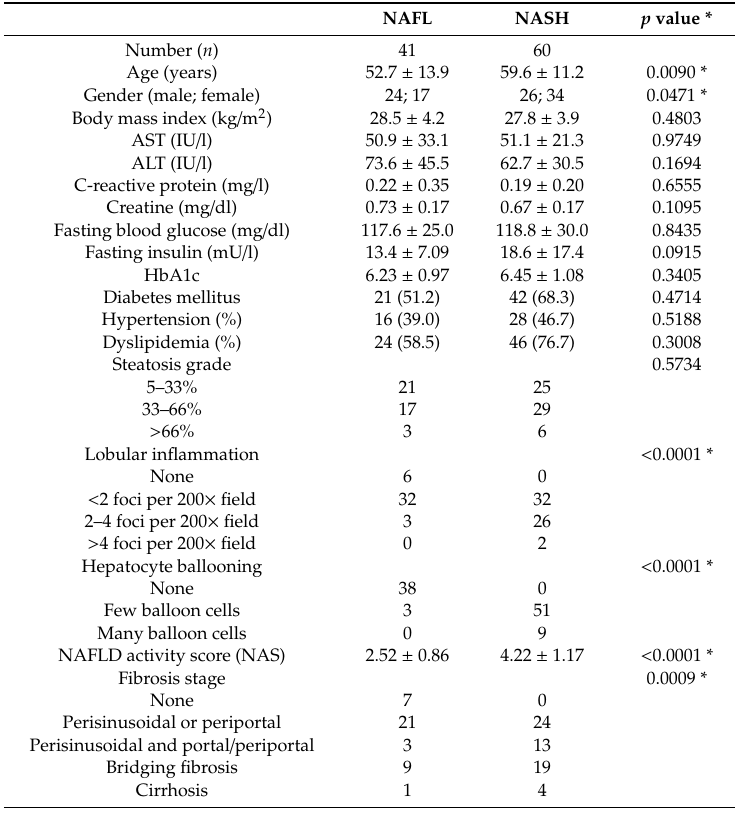
Table 1. Serological and histological characteristics in patients with NAFLD. *, statistical significance, p value < 0.05 in Univariate